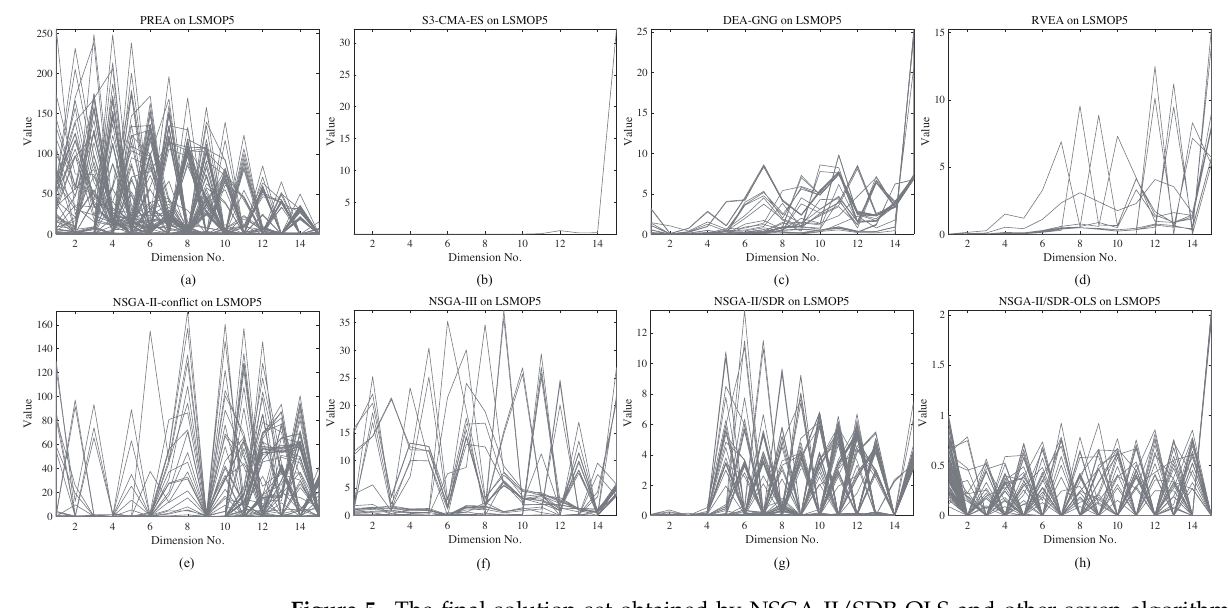
Figure 5. The final solution set obtained by NSGA-II/SDR-OLS and other seven algorithms on 15-objective LSMOP5. ( a ) The final solution set of PREA; ( b ) The final solution set of S3-CMA-ES; ( c ) The final solution set of DEA-GNG; ( d ) The final solution set of RVEA; ( e ) The final solution set of NSGA-II-conflict; ( f ) The final solution set of NSGA-III; ( g ) The final solution set of NSGA-II/SDR; ( h ) The final solution set of NSGA-II/SDR-OLS. DEA-GNG on LSMOP9 10002000300040005000600070008000900010000 u e V a l